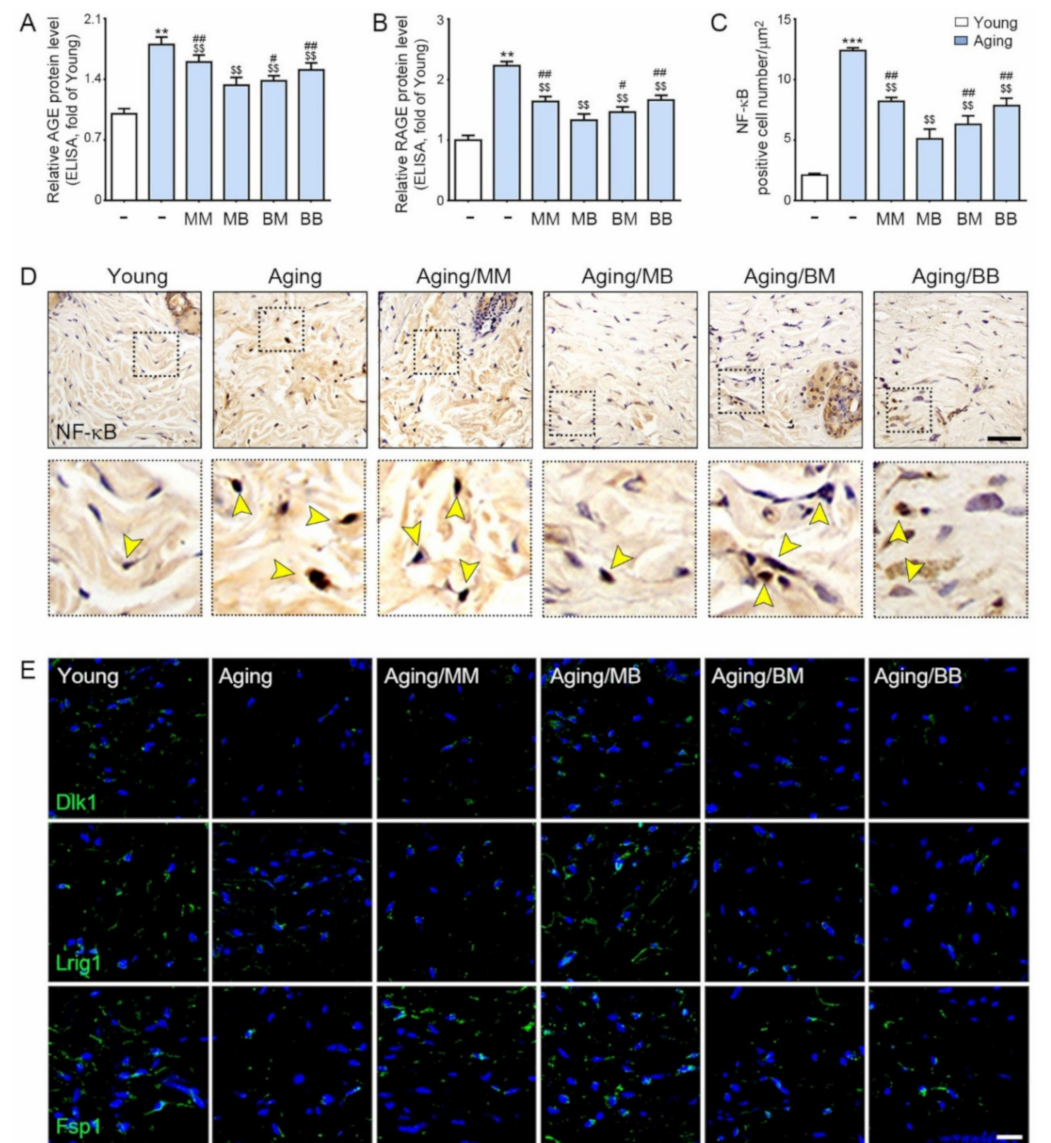
Figure 3. The recovery effect of NF- κ B by AGE, RAGE, and papillary and reticular fibroblasts depending on the combination of RF modes: ( A , B ) The protein expression levels of ( A ) AGE and ( B ) RAGE were determined in the skin tissue by ELISA. ( C ) Quantitative graphs represent the nuclear NF- κ B-positive cell number. ( D ) NF- κ B expression in the dermis of the aged mice skin were assessed immunohistochemically (scale bar = 100 µ m). The yellow arrows point to positive signals. ( E ) Immunofluorescence analysis showed the expression of Dlk1-, Lrig1-, and Fsp1-positive cells (green). Nuclei were stained blue using DAPI (scale bar = 100 µ m). Data are presented as mean ± SD. **, p < 0.01 and ***, p < 0.001, vs. Young; $$, p < 0.01, vs. Aging; #, p < 0.05 and ##, p < 0.01, vs. Aging/MB (Mann–Whitney U test). MM, monopolar mode applied twice; MB, application of monopolar mode followed by application of the bipolar mode; BB, bipolar mode applied twice; BM, application of bipolar mode followed by monopolar mode; AGE, advanced glycated end products; RAGE, rage of advanced glycated end products; NF- κ B, nuclear transcription factor- κ B; Dlk1, delta- like non-canonical notch ligand 1; Lrig1, leucine-rich repeats and immunoglobulin-like domains 1; Fsp1, ferroptosis suppressor protein